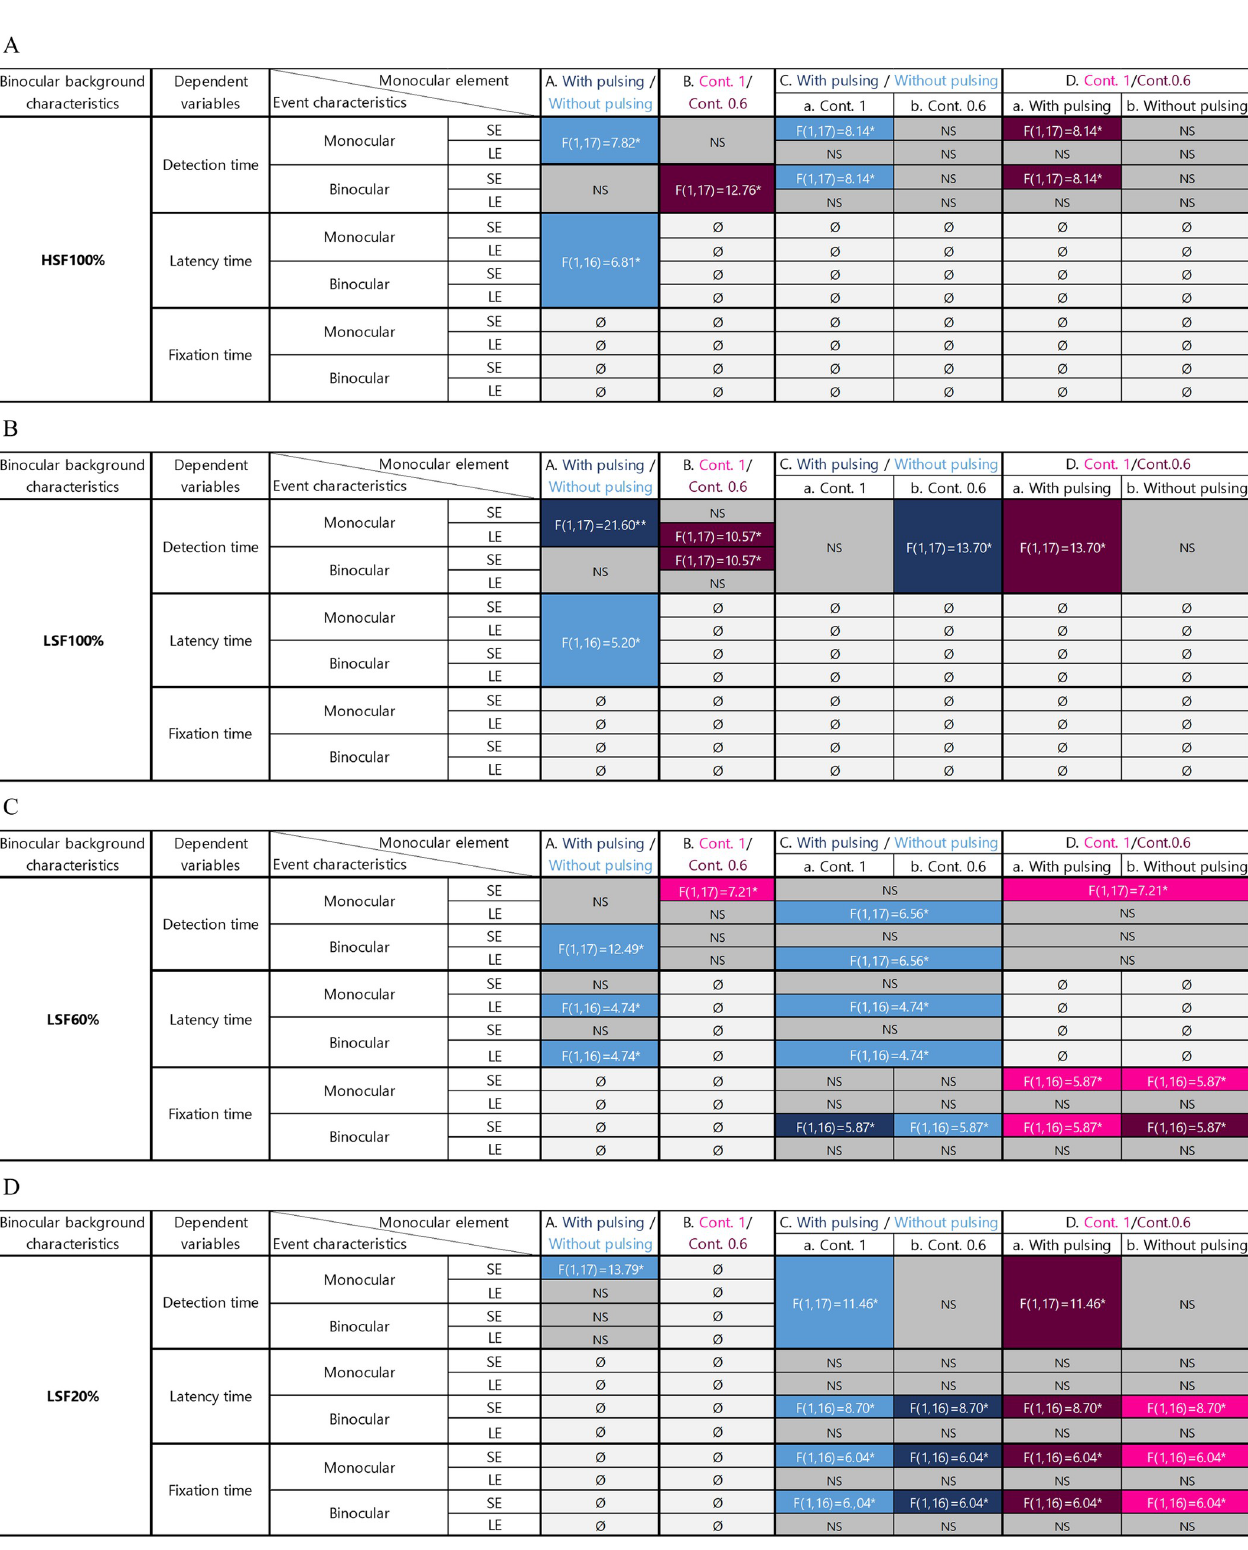
Fig 12. Repeated measures ANOVA of event detection , latency and fixation times as a function of the characteristics of the monocular element and the event display mode in the HSF-100% (A), LSF-100% (B), LSF-60% (C) and LSF-20% (D) conditions. In these tables, event display parameters are presented in rows